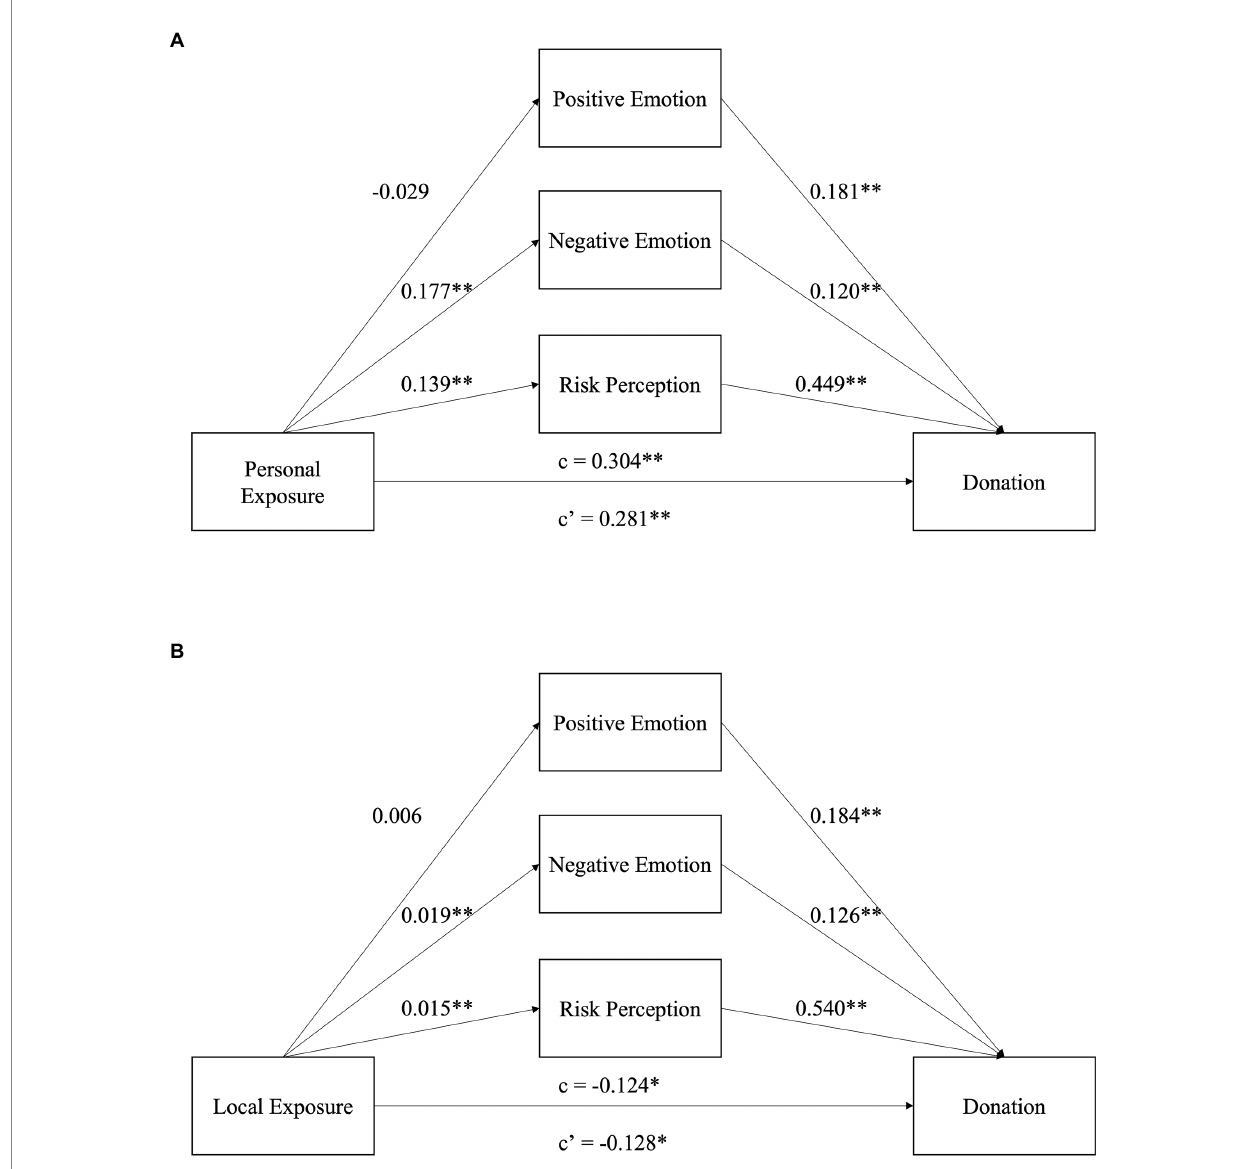
FIGURE 2 The mediation model of the relationships between personal exposure and donation and between local exposure and donation. (A) The mediation model of personal exposure with positive emotion, negative emotion, and risk perception as mediators. (B) The mediation model of local exposure with positive emotion, negative emotion, and risk perception as mediators. * p < 0.05, ** p < 0.01. c, total effect; c’, direct